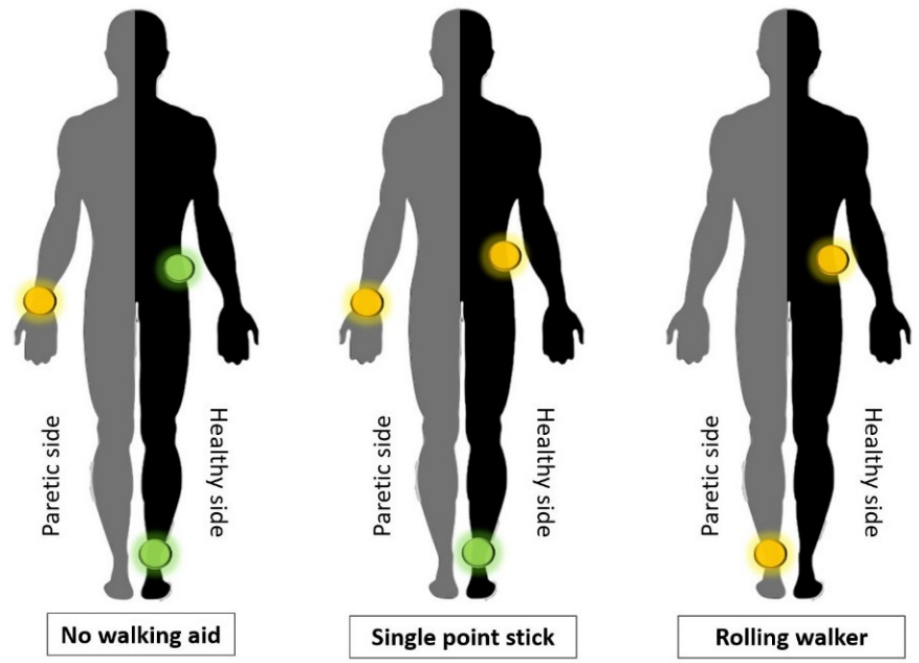
Figure 2. Graphical interpretation of the most accurate position of the trackers for given placement on the body.